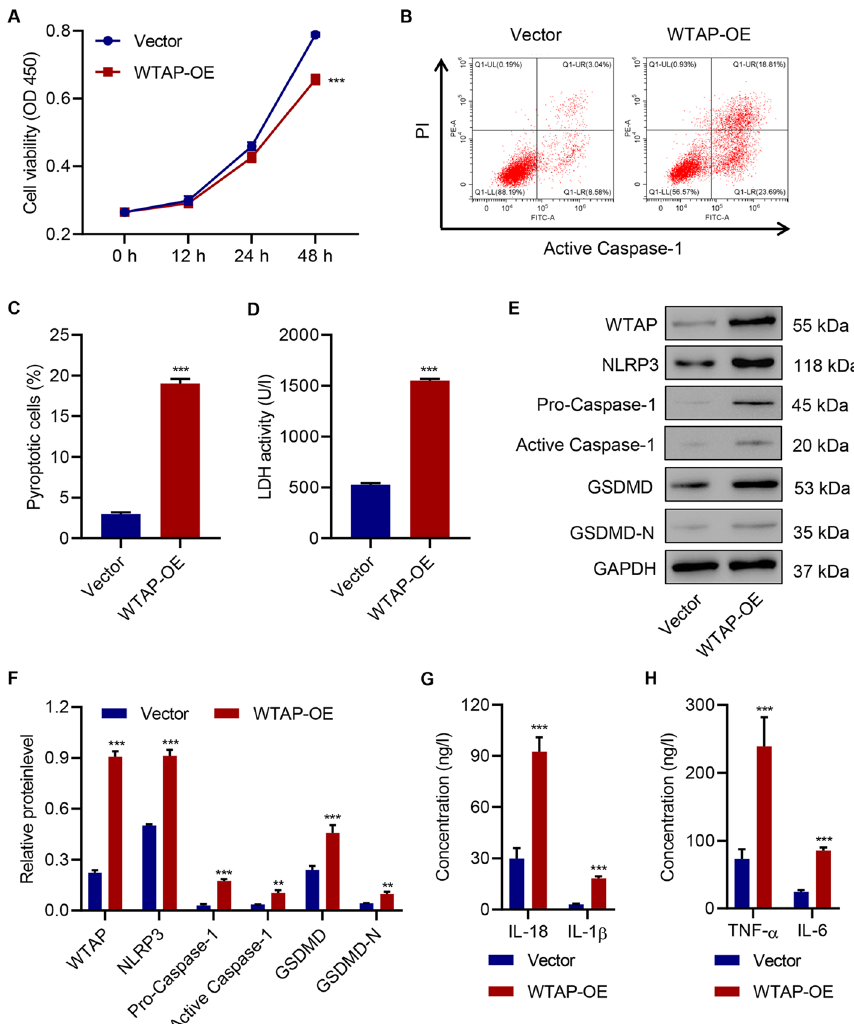
Fig. 3 WTAP overexpression promotes cell pyroptosis and pro-inflammatory factor release in HK-2 cells. A Cell viability; ( B , C ) cell pyroptosis; ( D ) LDH activity; ( E , F ) expression of WTAP, NLRP3, pro-caspase-1, active caspase-1, GSDMD and GSDMD-N; and ( G , H ) the release of IL-18, IL-1β, TNF-α, and IL-6 in HK-2 cells with or without WTAP overexpression ( n 3). Unpaired Student’s t -test was used for the analysis between two = groups. ** P < 0.01, *** P < 0.001 compared with